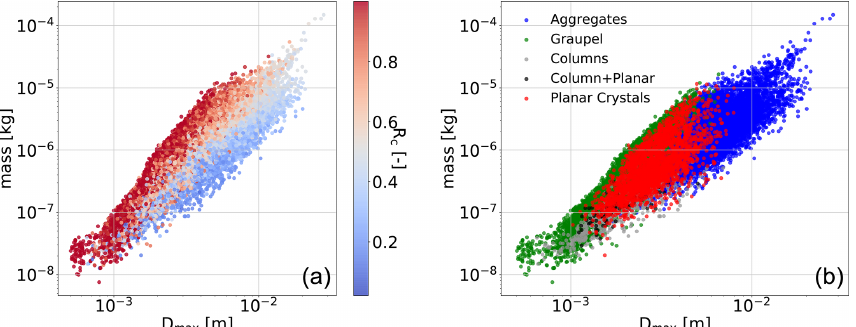
Figure 5. m(D max ) scatterplots for the data of a field campaign, named Davos 2015, which took place in the Swiss Alps in 2015 and 2016. (a) Data are color-coded according to riming index R c by Praz et al. (2017). (b) Data are color-coded according to the hydrometeor classes, also by Praz et al. (2017). Table 4. Values of the parameters of the relation m = a m D b m max estimated on the datasets of different field campaigns for various degrees of riming. m is estimated with 3D-GAN, while R c is the normalized riming index as in Praz et al. (2017), averaged over the three camera views. D max is the maximum dimension obtained from the triplet of images of the